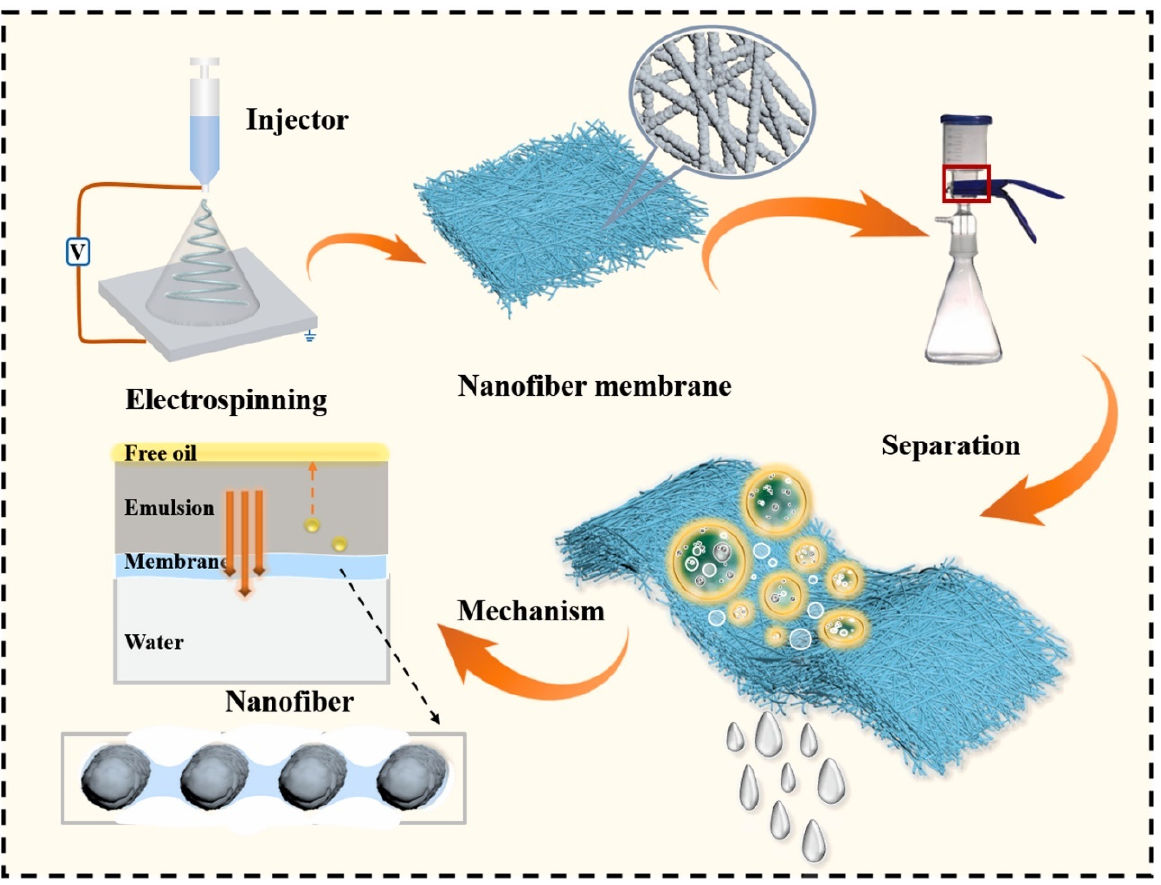
Figure 6. Fabrication of blend containing polyvinylidene difluoride and TiO 2 nanoparticles into a membrane for oil–water separation. Adapted with permission from Du et al. [205] . Copyright (2021) Elsevier.